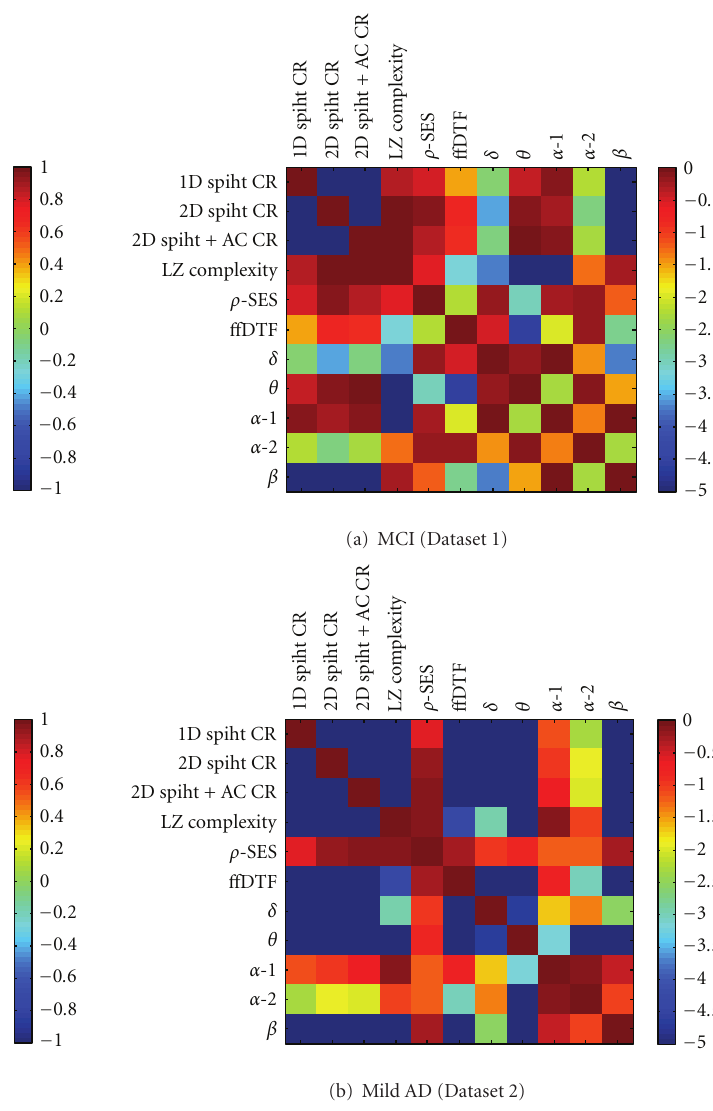
Figure 6: Correlation between the lossless compression ratios, LZ complexity, relative power in di ff erent bands, Granger causality ( ff DTF), and stochastic event synchrony ( ρ ); red and blue indicate strong correlation and anticorrelation, respectively.